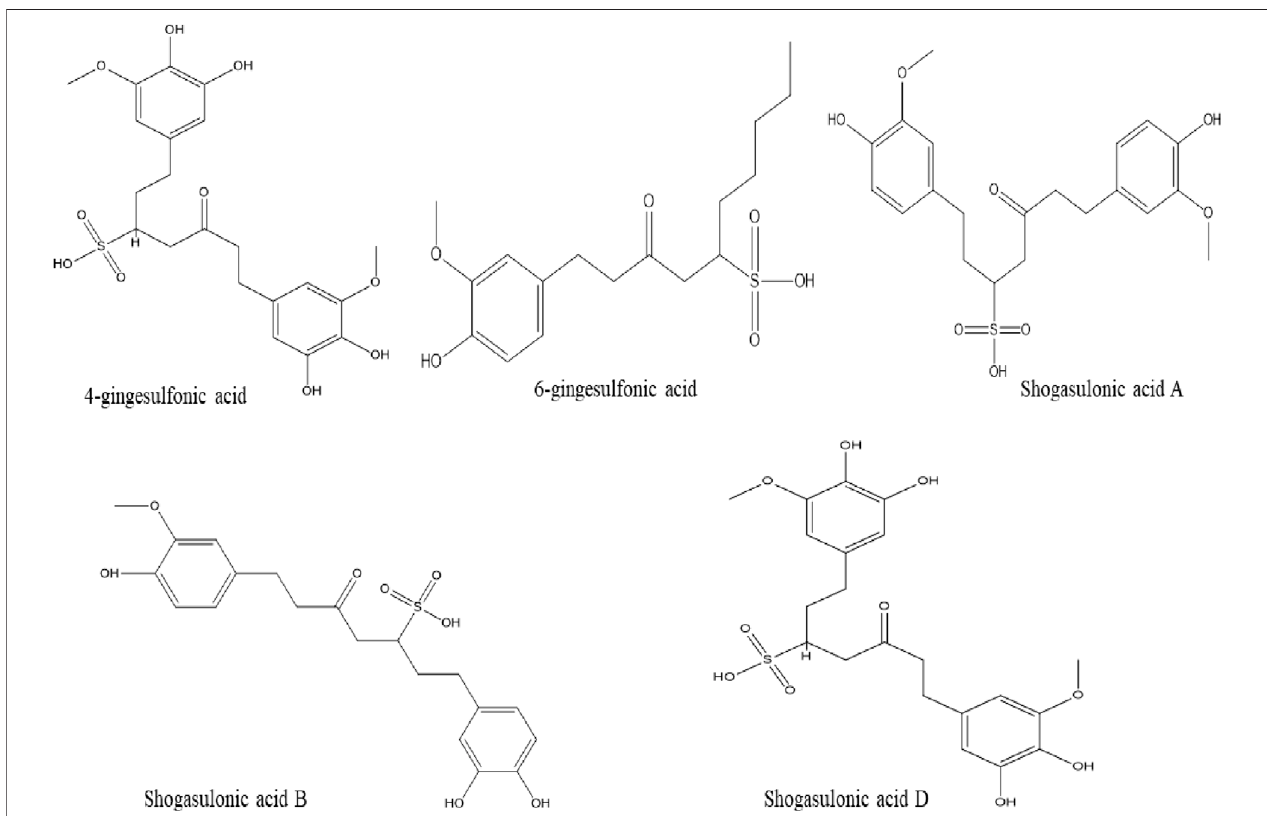
FIGURE 3 | Chemical structures of phenylalkanoids and sulfonates compound isolated from ginger.